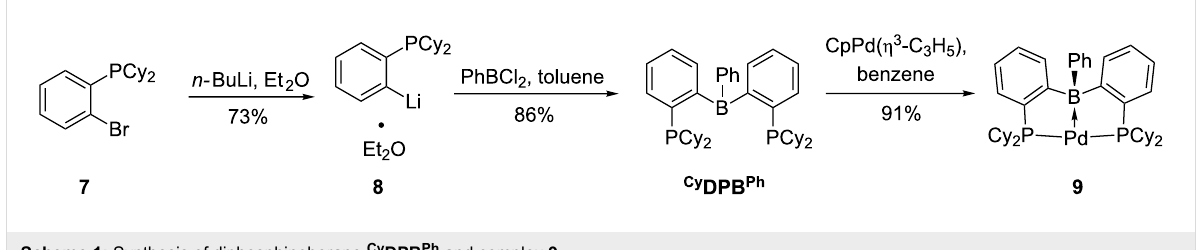
Scheme 1: Synthesis of diphosphinoborane Cy DPB Ph and complex 9